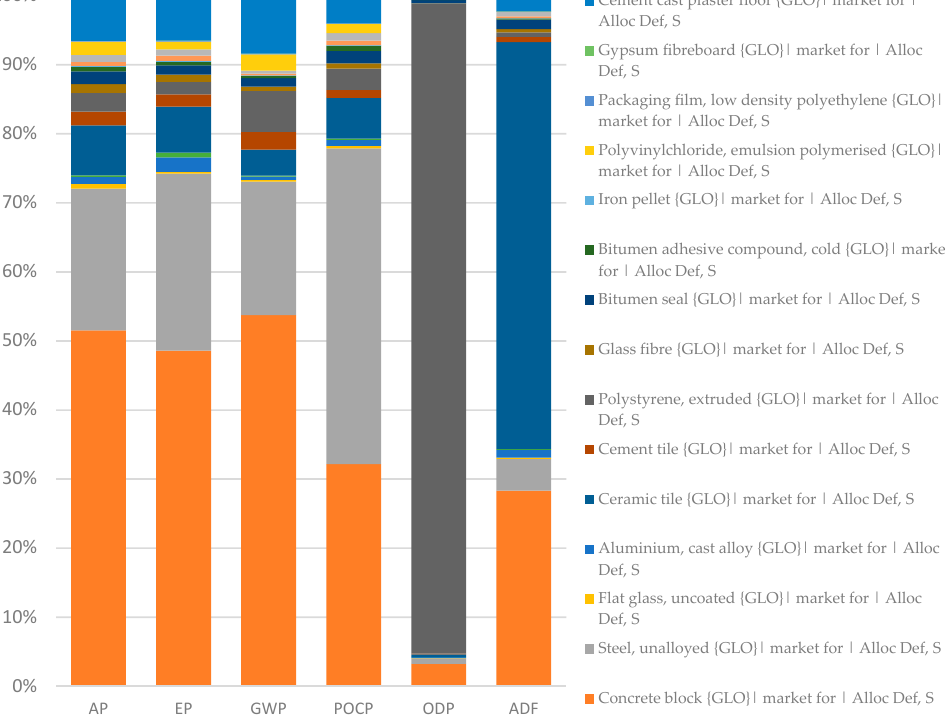
Figure 7. Environmental impacts of materials.